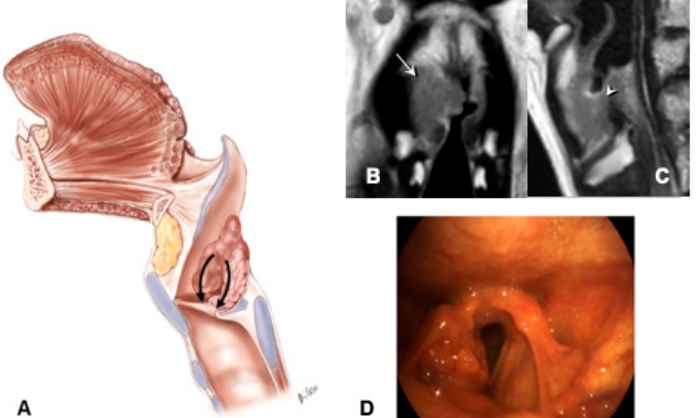
Figure 2. Pattern 1: Supraglottic carcinoma encasing the arytenoid from above with fixation due to weight effect, without direct invasion of the CAU: ( A ) sagittal scheme. ( B ) Coronal T2-weighted MR image shows a supraglottic tumor that involves the superior paraglottic space on the right side (arrow) and invades the glottis. ( C ) Sagittal T2-weighted image demonstrates that the lesion encases the right arytenoid that appears diffusely hypointense because of sclerosis suspicious for invasion (arrowhead), without clear evidence of CAU involvement. ( D ) Endoscopic view.